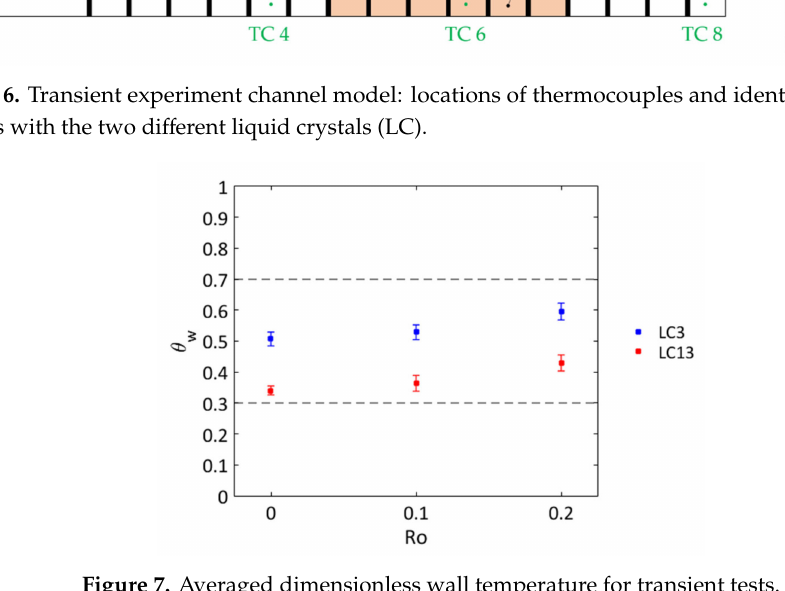
Figure 7. Averaged dimensionless wall temperature for transient